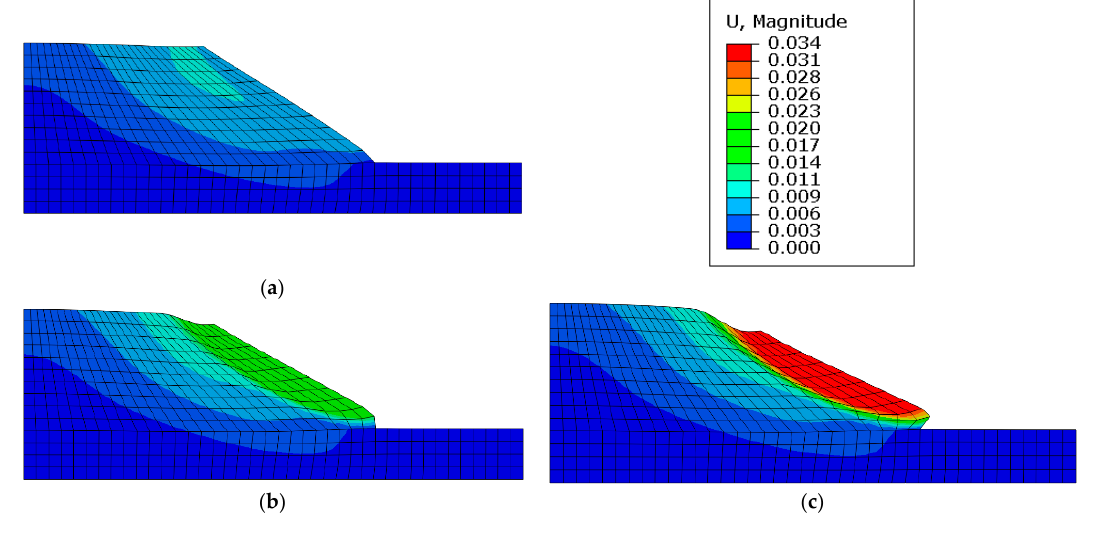
Figure 5. Variations of saturation in the FE infiltration analysis: ( a ) t = 10.6 h; ( b ) t = 20.2 h; ( c ) t = 40 h.